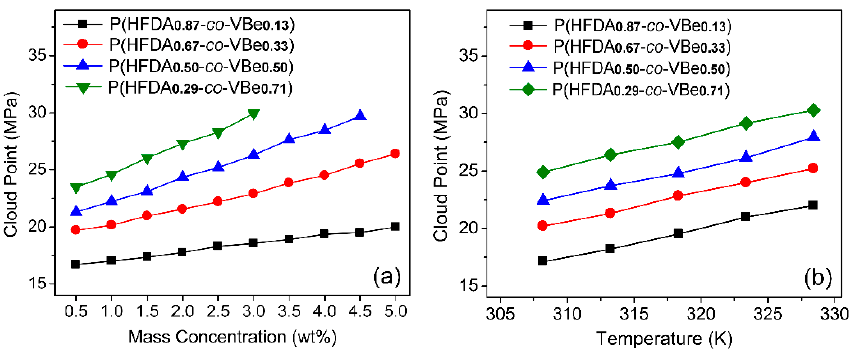
Figure 4. Cloud point pressures of the co-polymer–CO 2 solutions versus mass concentration at 308.2 K ( a ) and temperature (b) at 1 wt. % of concentration.